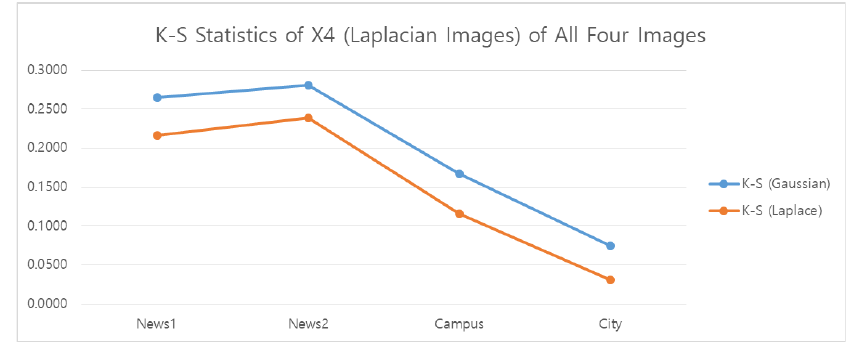
Figure 15. Kolmogorov-Smirnov Test Statistics for X4.